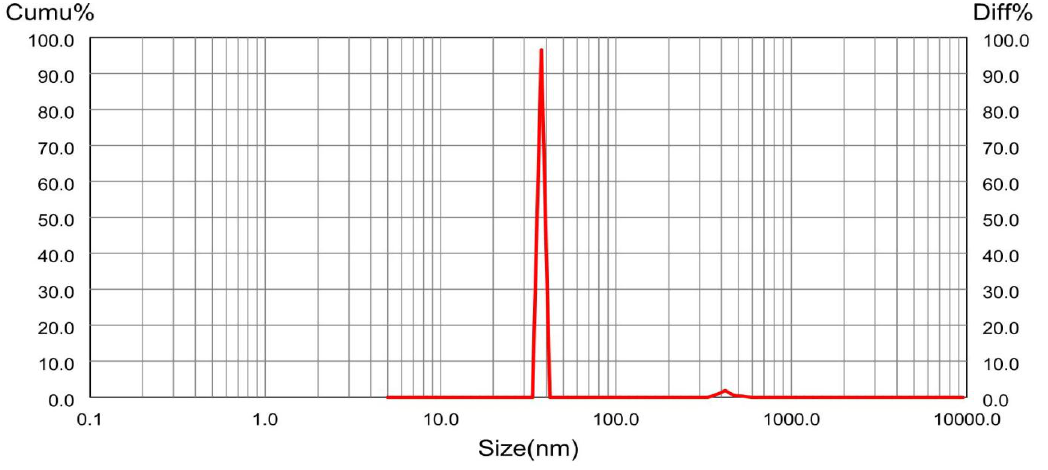
Figure (12): Particle size distribution of F21 by particle size analyzer